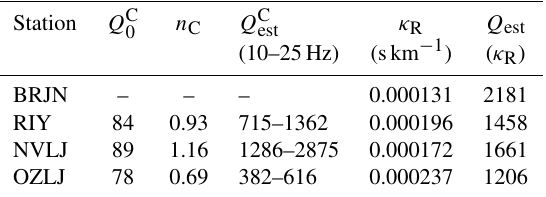
Table 3. Values of Q C and n C for the elapsed time of the coda wave 0 window t L = 30s (Dasovi´c, 2015 – most recent values), Q C est es- timated for the high-frequency range (10–25Hz) from Q C est (f ) = Q C f n and frequency-independent Q est κ R . There is no published 0 C information for the BRJN station regarding the existence of the frequency-dependent ( f ).